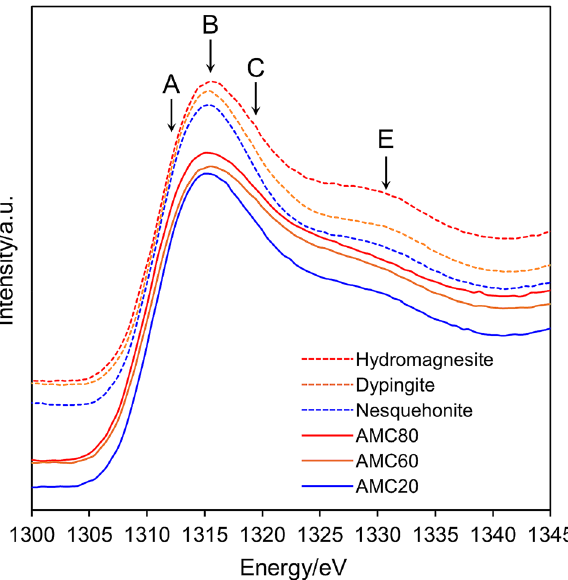
Figure 5. Mg K-edge XANES spectra of AMC samples obtained at 20, 60, and 80 °C (denoted as AMC20, AMC60, and AMC80, respectively) and nesquehonite, dypingite, and hydromagnesite crystalline magnesium carbonate hydrates obtained by stirring AMC suspensions for 2 h at 20, 60, and 80 °C, respectively. The letters A to E denote each peak in the paper by Finch and Allison 24 .